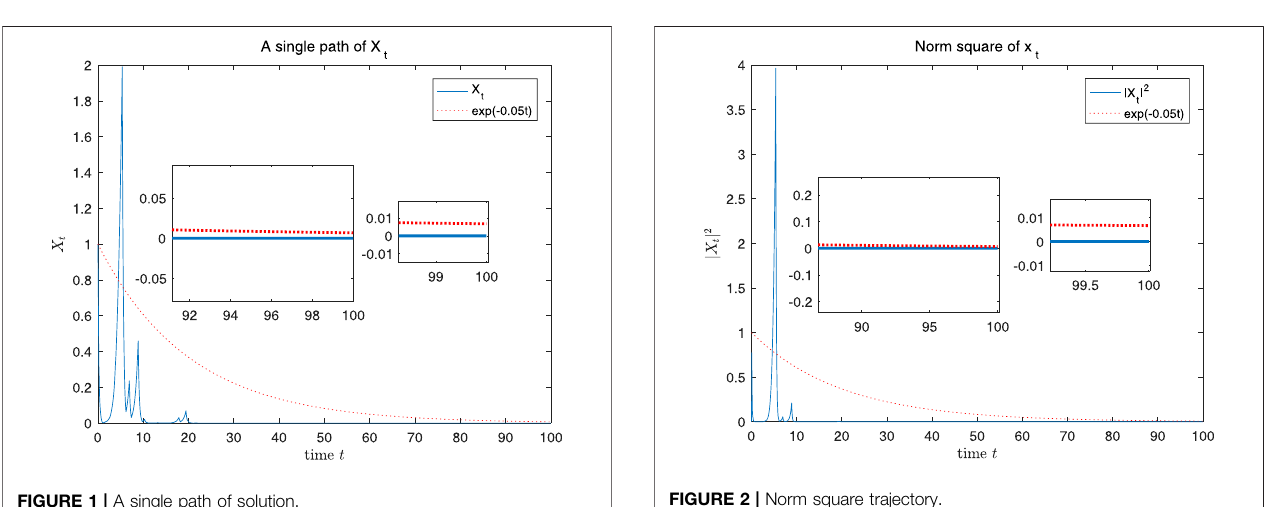
FIGURE 1 | A single path of solution. FIGURE 2 | Norm square